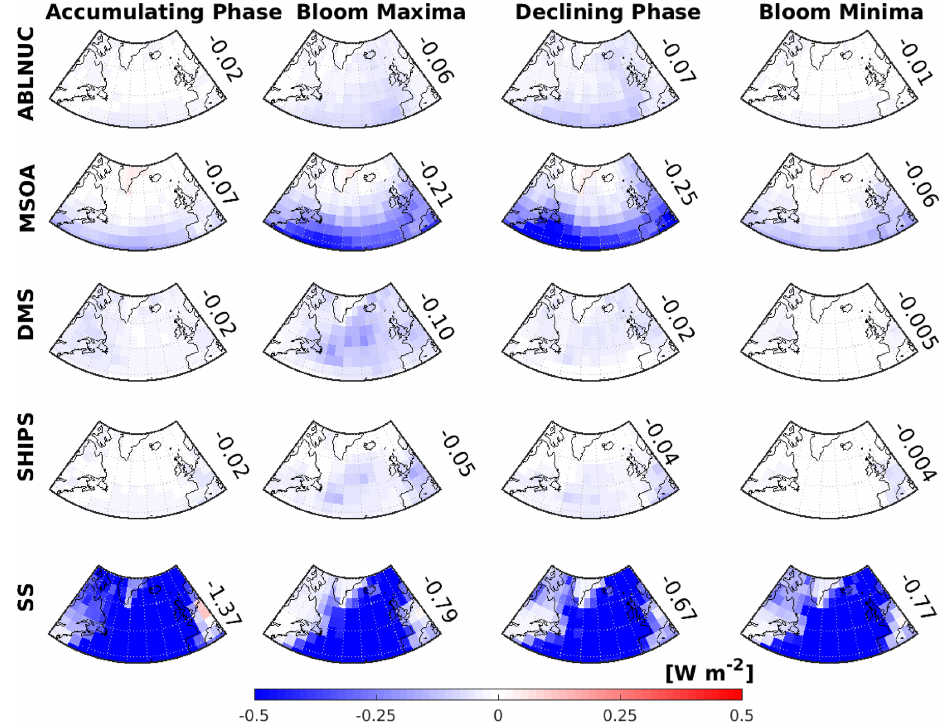
Figure 7. GEOS-Chem-TOMAS-simulated 2-month-mean aerosol direct radiative effect (DRE) attributed to five key factors. Top row: above-boundary-layer particle nucleation (ABLNUC); second row: particle growth by marine secondary organic aerosol (MSOA); third row: particle formation and growth due to DMS-oxidation products (DMS); fourth row: shipping emissions contribution to particles (SHIPS); and bottom row: sea spray (SS). DREs are in columns for the following time periods, March/April 2018 (accumulating phase), May/June 2016 (climax transition, bloom maxima), August/September 2017 (declining phase), and October/November 2015 (winter transition, bloom minima). DREs for ABLNUC, MSOA, DMS, SHIPS, and SS are calculated using the differences in the top-of-the-atmosphere solar flux between simulation BASE and respective sensitivity simulations (noABLNUC, noMSOA, noDMS, noSHIPS, noSS). Values shown are area-weighted-mean DREs over the region bounded by 40–60 ◦ N and 20–50 ◦